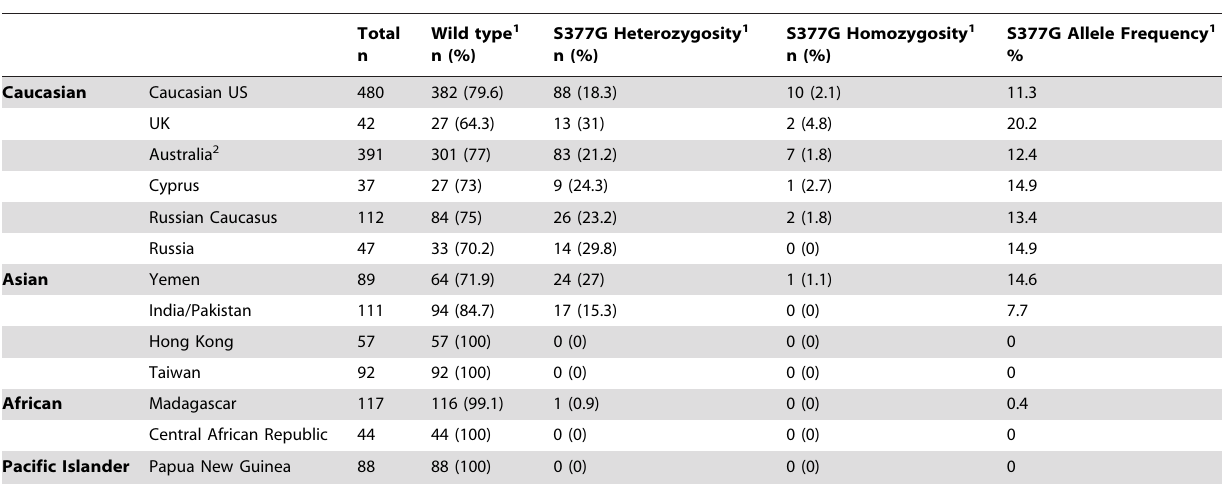
Table 1. S377G allele distribution in indigenous human